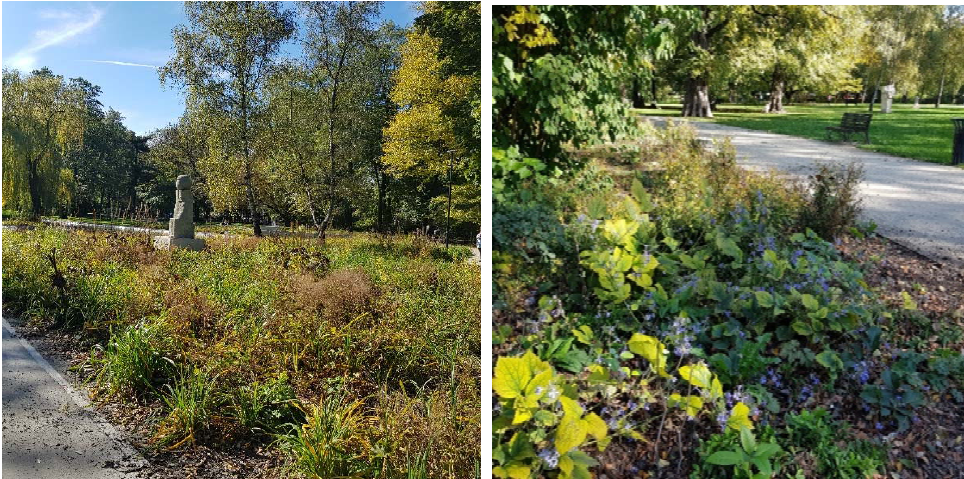
Figure 8. Krakowski Park, perennial meadows as a “leading aspect” ( left ), and open-air sculpture gallery ( right ), designer : Gajda Architektura Krajobrazu, LUZ Landschaftsarchitekten München (Pho- gallery ( right ), designer: Gajda Architektura Krajobrazu, LUZ Landschaftsarchitekten München (Photos tos by the Authors, 2021). by the Authors,